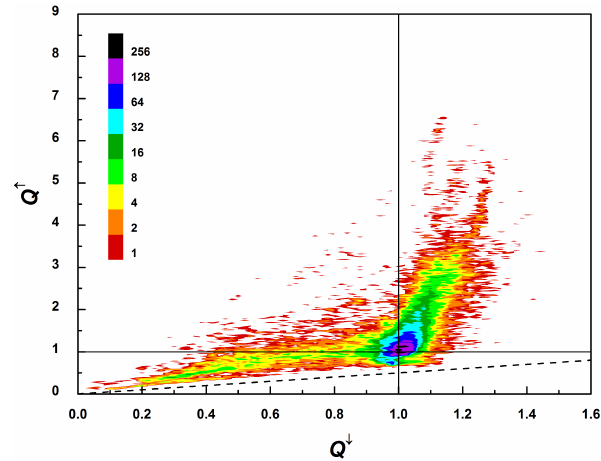
Fig. 6. Correlation of observed to model (clear sky) actinic flux ratios for up-welling and down-welling radiation observed during INTEX-NA (all flights). Color scale gives frequency of occurrence of values. Dashed line give approximate the lower bound of ob- served